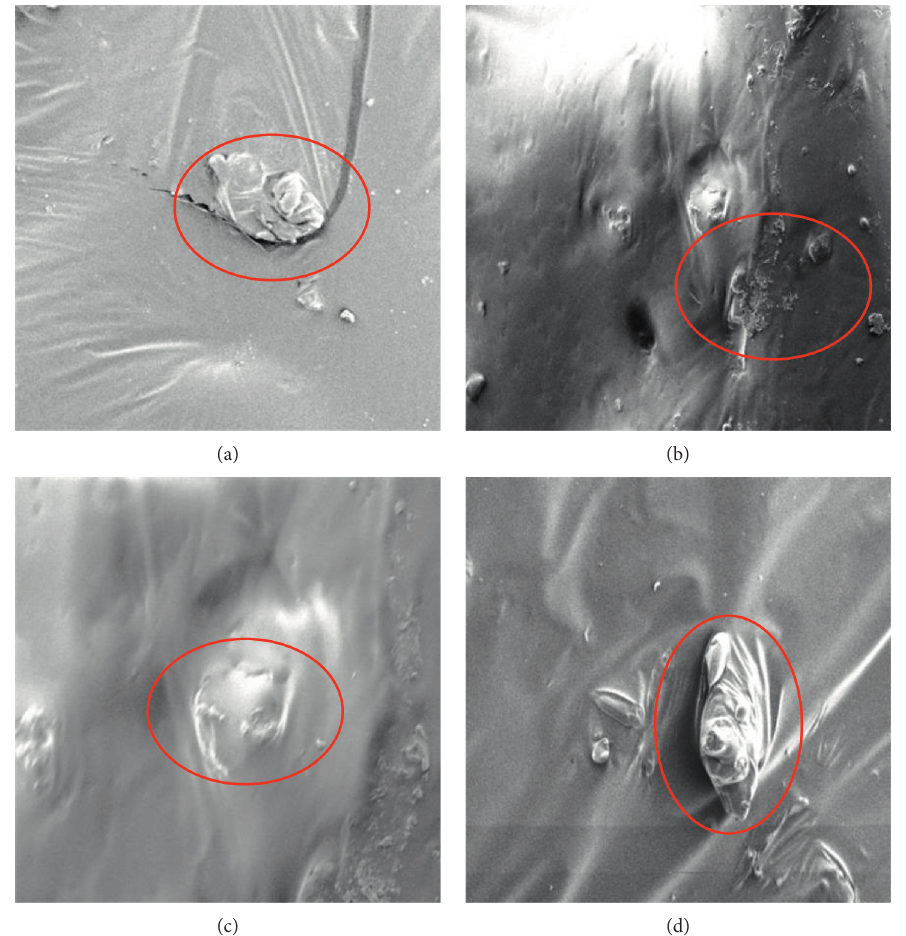
Figure 6: Mirror image of ordinary rubber powder-modified asphalt and activated rubber powder-modified asphalt: (a) ordinary rubber powder-modified asphalt ( × 200), (b) activated rubber powder-modified asphalt ( × 200), (c) ordinary rubber powder-modified asphalt ( × 500), and (d) activated rubber powder-modified asphalt ( × 500).